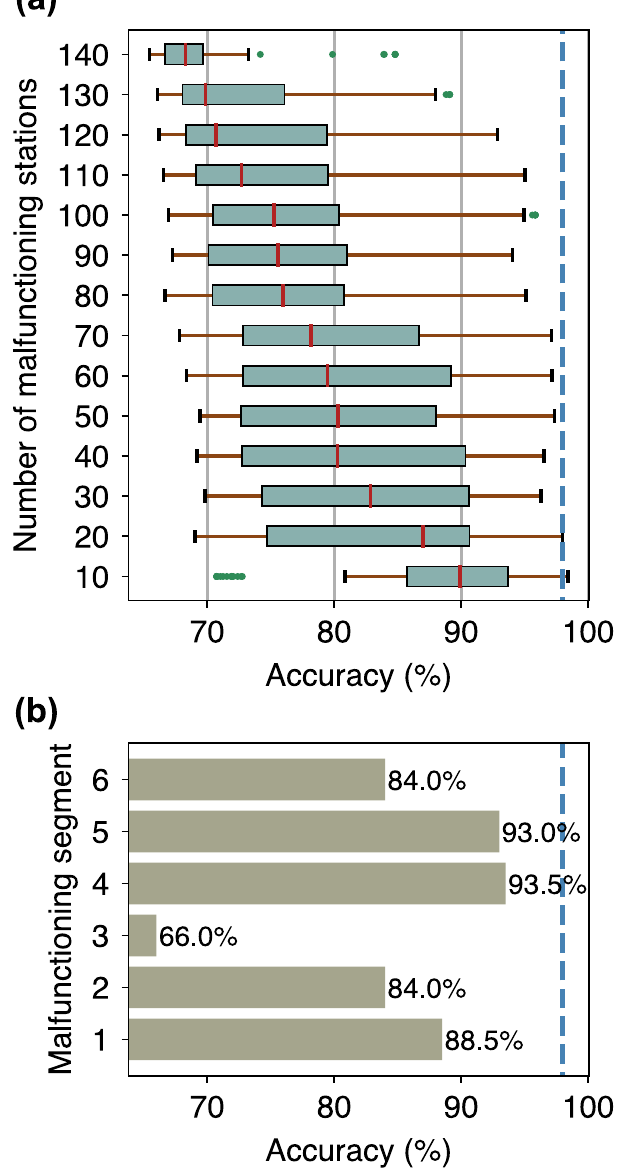
Fig. 6 | Prediction accuracies relative to malfunctioning stations. a Box plot of prediction accuracies with respect to the number of malfunctioning stations. b Prediction accuracies relative to a malfunctioning S-net segment. The dashed blue line marks the prediction accuracy without malfunctioning stations or